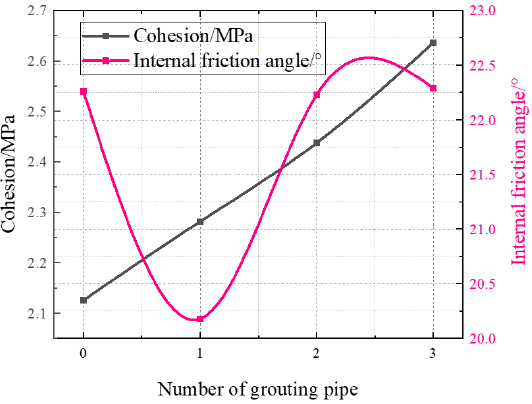
Figure 10. Internal friction angle and cohesion of specimen containing grouting pipe.